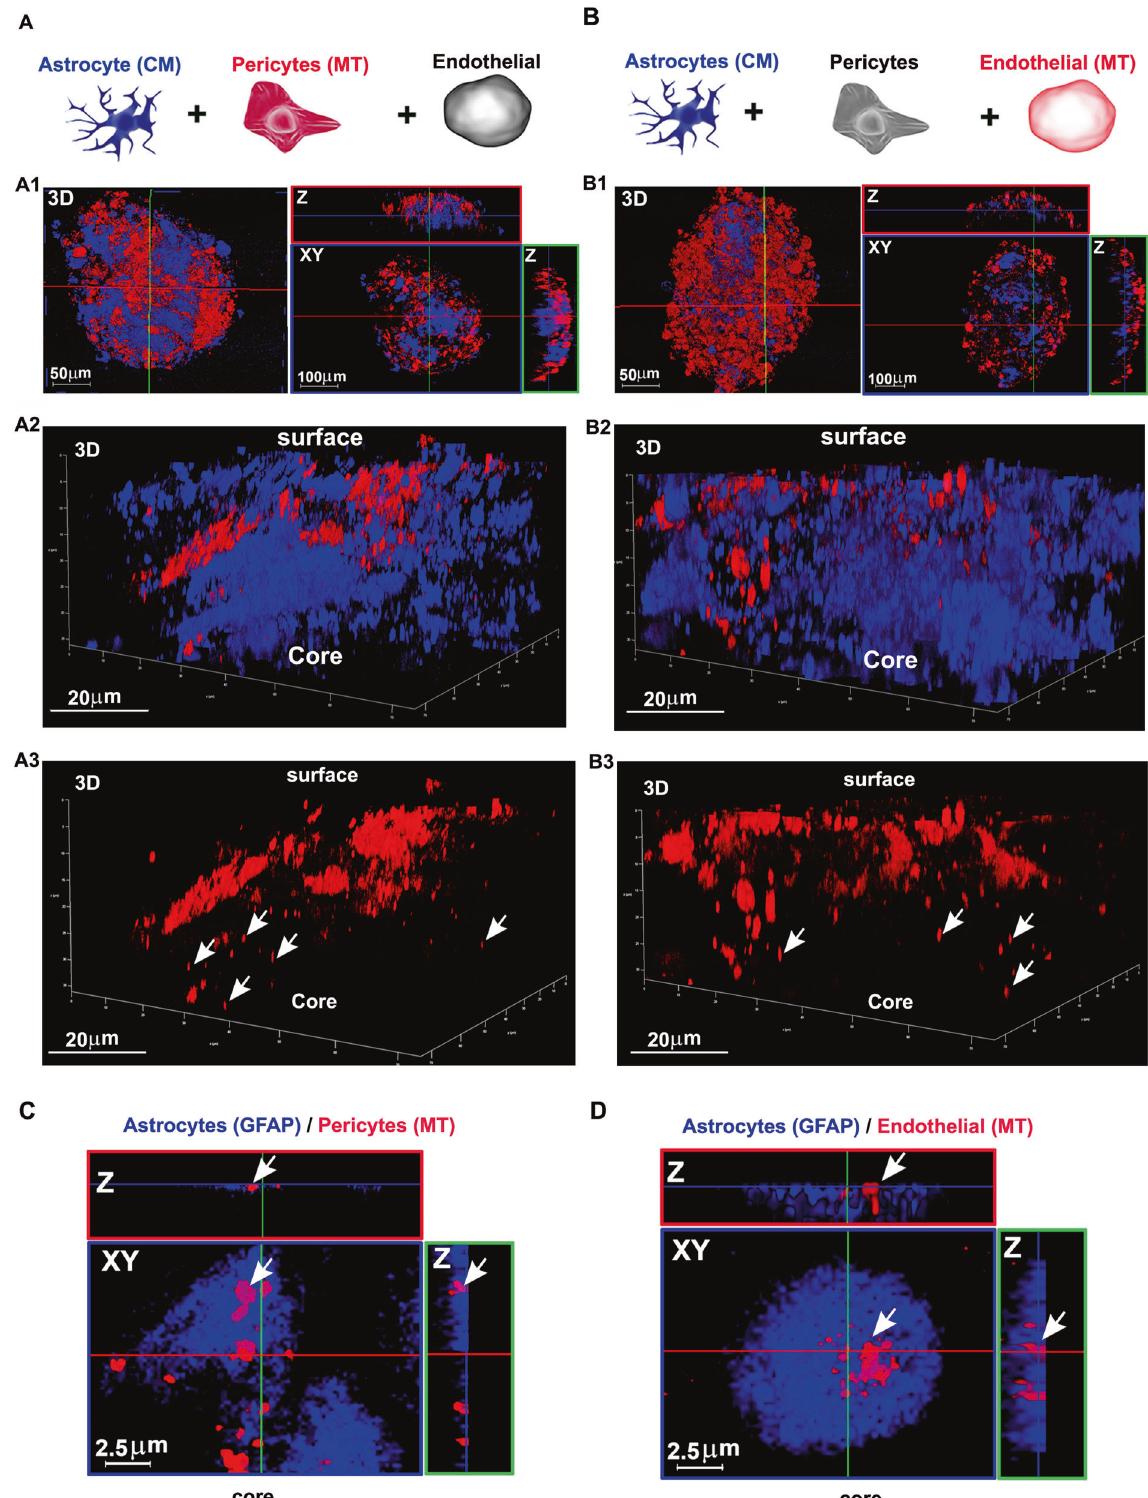
small amount of mitochondria from pericytes was found in some STS-treated astrocytes with healthy morphology also in the presence of VCR. As in the case of CytoD, this could be due either to the presence of a low percentage of TNT resistant to VCR